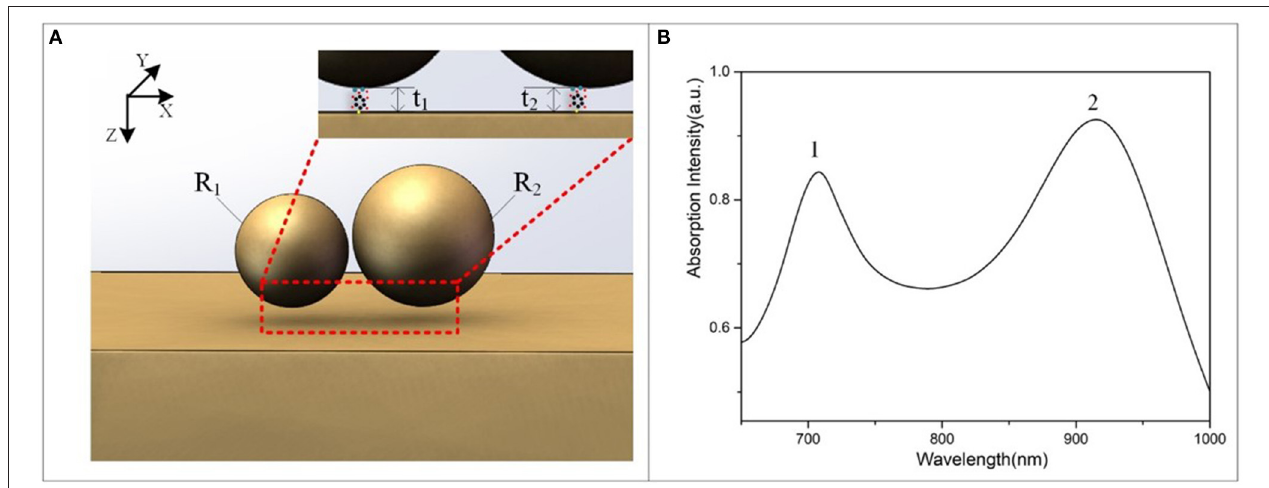
FIGURE 1 | (A) The schematic of Au nanosphere dimer–dielectric–Au film plasmonic nanostructures. The radii of two Au nanospheres are R 1 and R 2 , respectively. The thickness of the dielectric layer under two Au nanospheres is t 1 and t 2 , respectively. The Au film has a thickness of D . (B) The calculated absorption cross-section of the structure ( R 1 = R 2 = 100nm, t 1 = t 2 = 1nm, D = 200